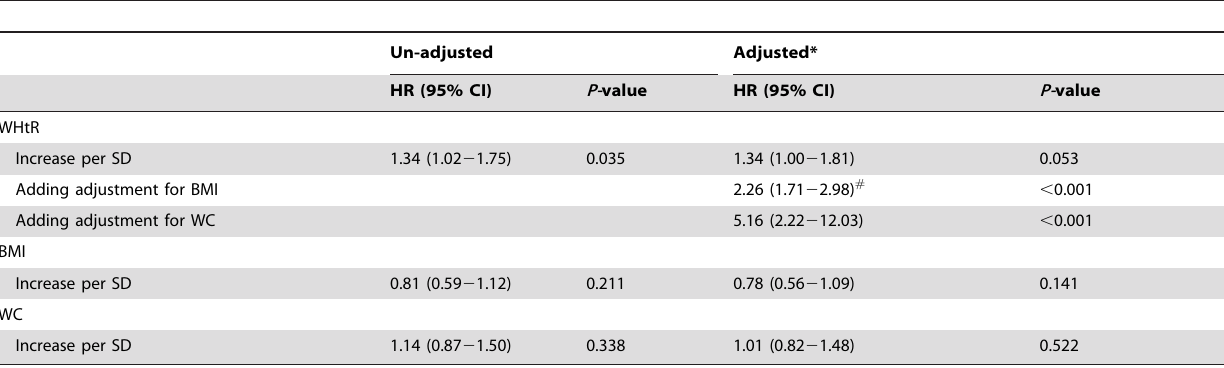
Table 3. Hazard Ratios and 95% Confidence Intervals of Ischemic Stroke for a 1-SD Increase in Anthropometric